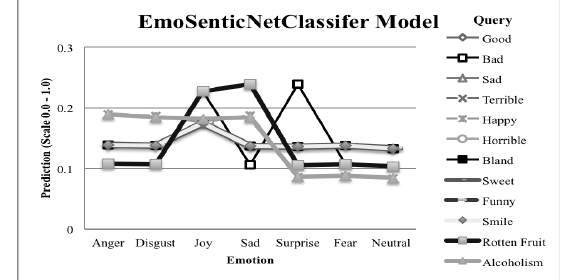
Figure 5. EmoSenticNetClassifer prediction